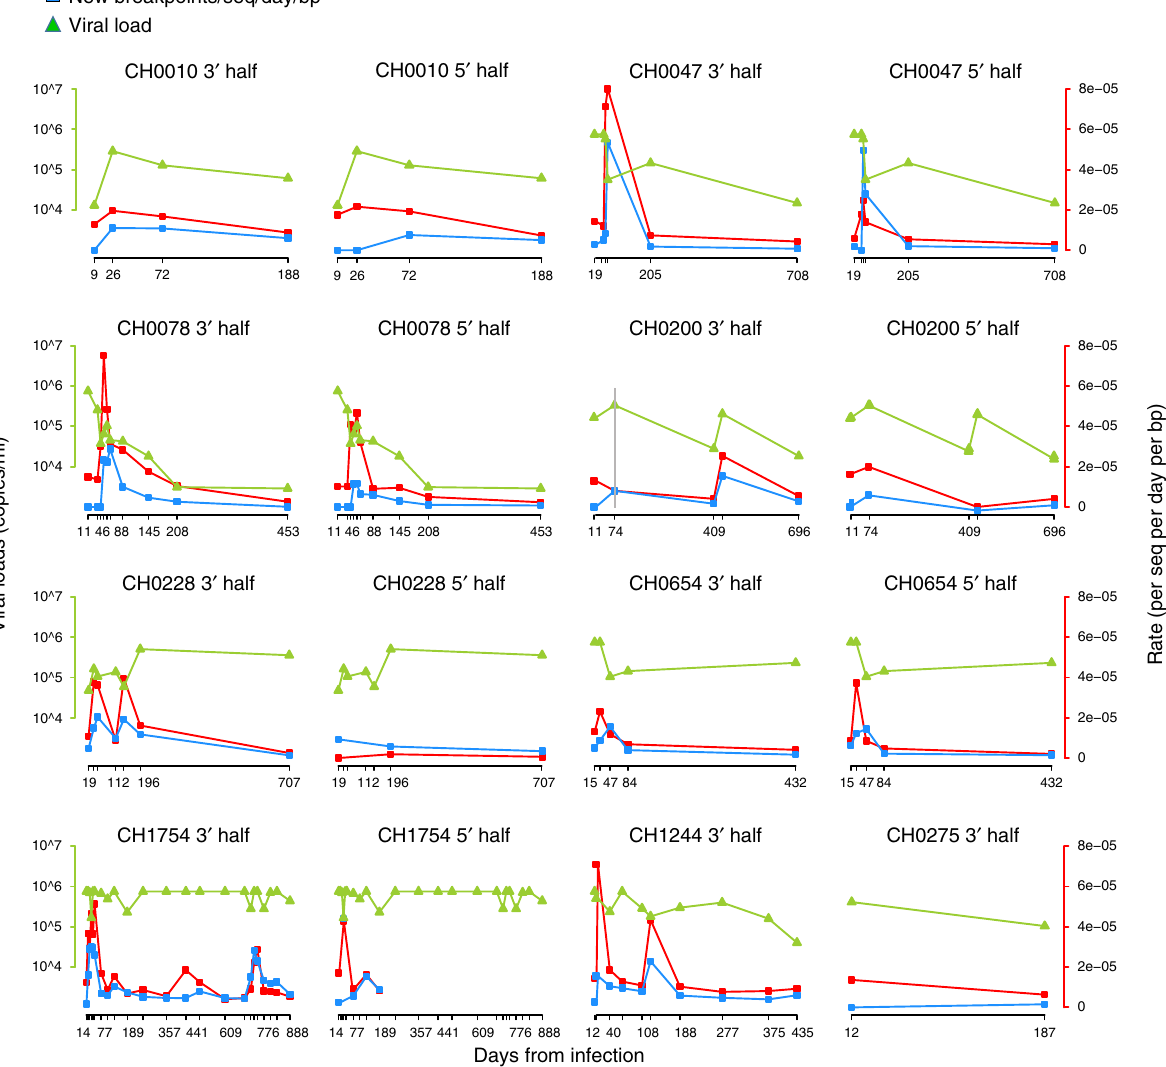
Fig. 5 Comparison of new breakpoint and mutation rates. Each graph shows the accumulation rate of new breakpoints per sequence per nucleotide per day (blue lines), new mutations per sequence per nucleotide per day (red lines), and log-scale viral loads (green lines) in both half genomes over time for all nine participants. Upper VL detection limit is 750,000 copies/ml. The gray vertical line in CH0200 3 ′ half highlights the time point at which a superinfecting T/F was observed. The sequences from the last time point (day 432) in CH0654 were excluded from the analysis due to the initiation